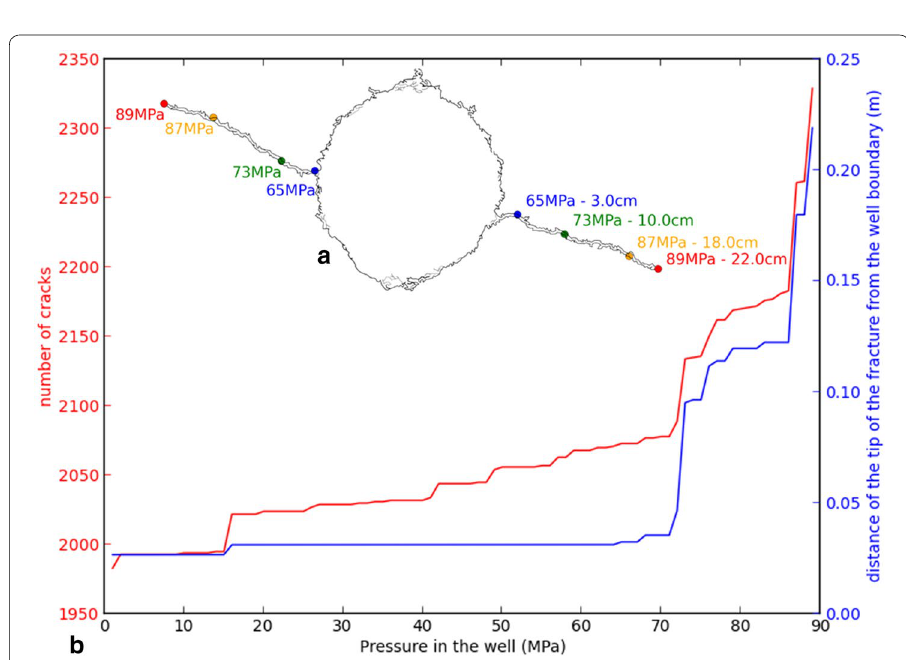
Fig. 13 Fracture propagation depending on the hydraulic pressure in the wellbore for case C. a Evolution of the wellbore shape—tip of the induced fracture is represented by a dot for different levels of pressure in the wellbore; b plot of the number of cracks (in red) and of the maximum distance of the tip of the fracture from the wellbore (in blue) depending on pressure in the